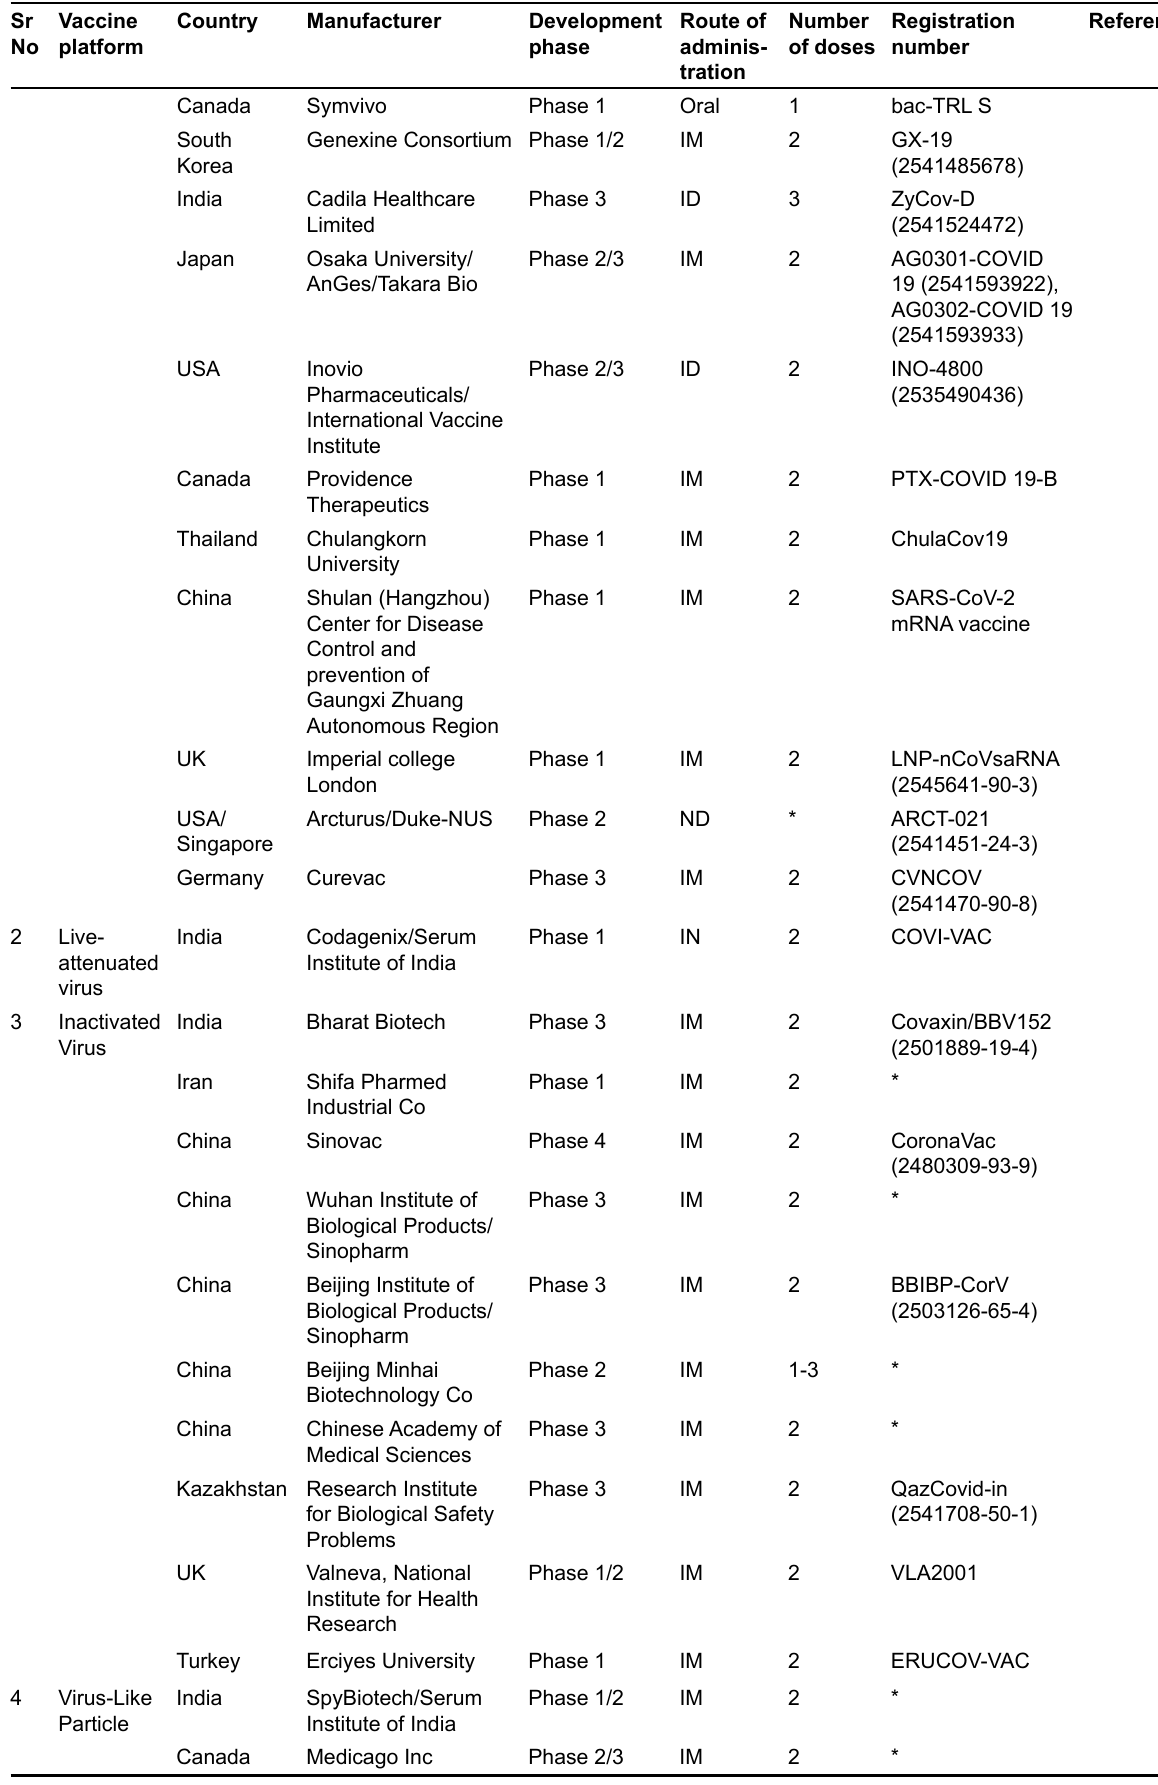
Table 2. Current development status of COVID-19 vaccine ( continued ) Sr No